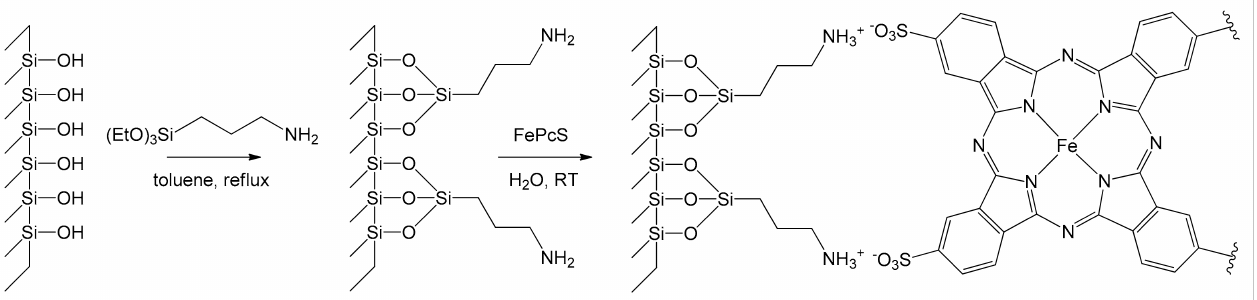
Figure 8. Immobilization of FePcS on the inner surface of functionalized mesoporous MCM-48 and MCM-41 silica substrates